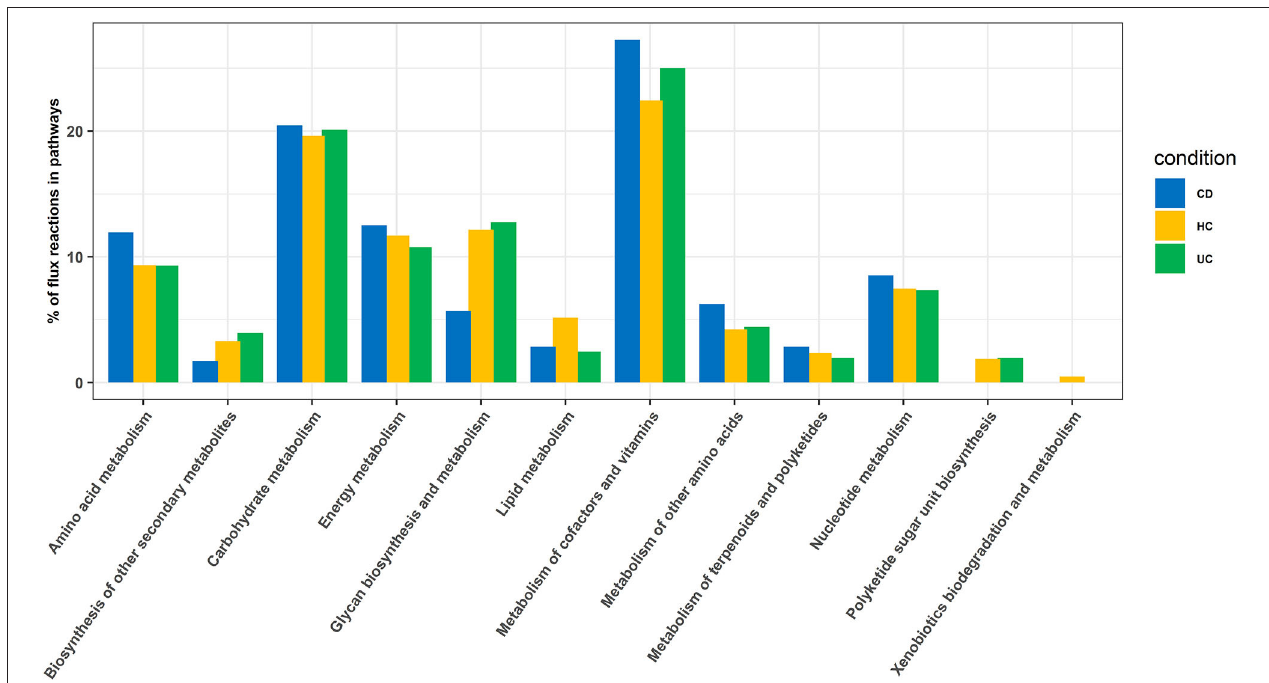
FIGURE 5 | Enriched pathways identified based on enriched metabolic reactions in disease-specific organisms for HC, CD, and UC